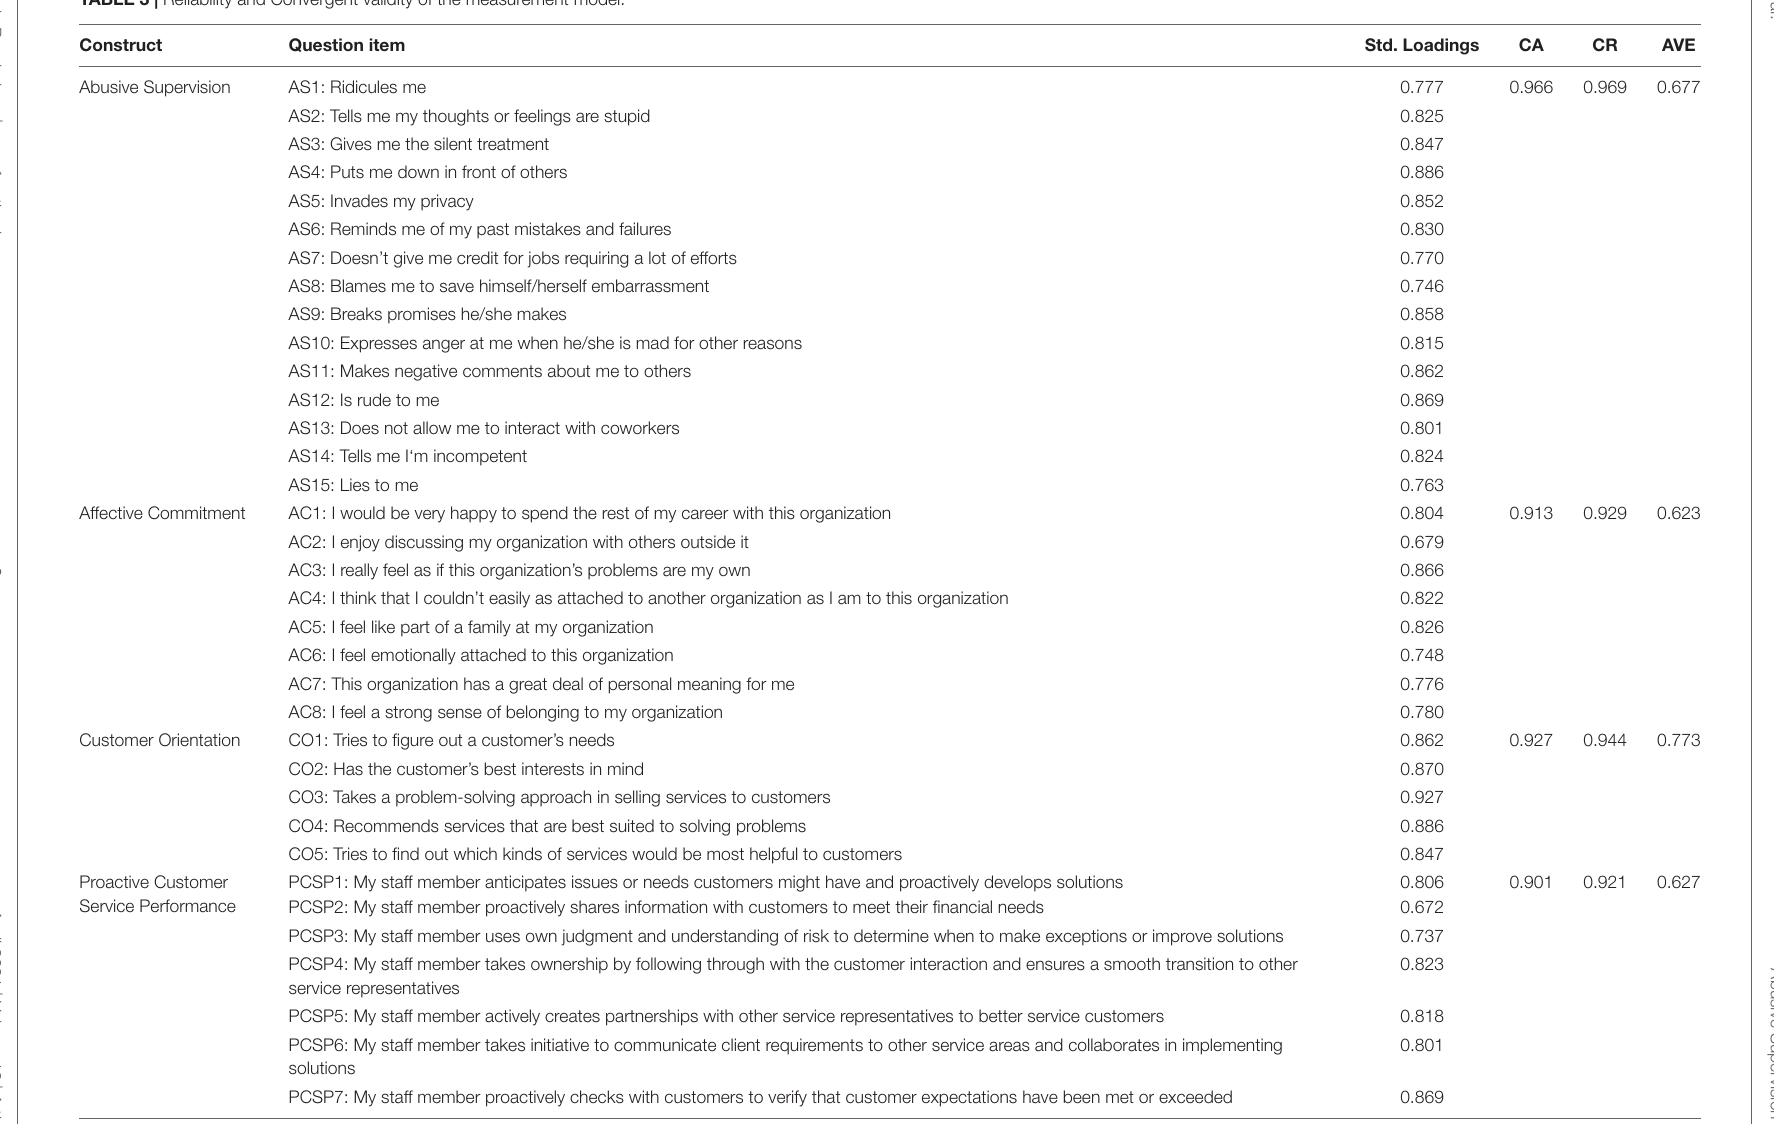
TABLE 3 | Reliability and Convergent validity of the measurement model. Construct Question item Std. Loadings CA CR